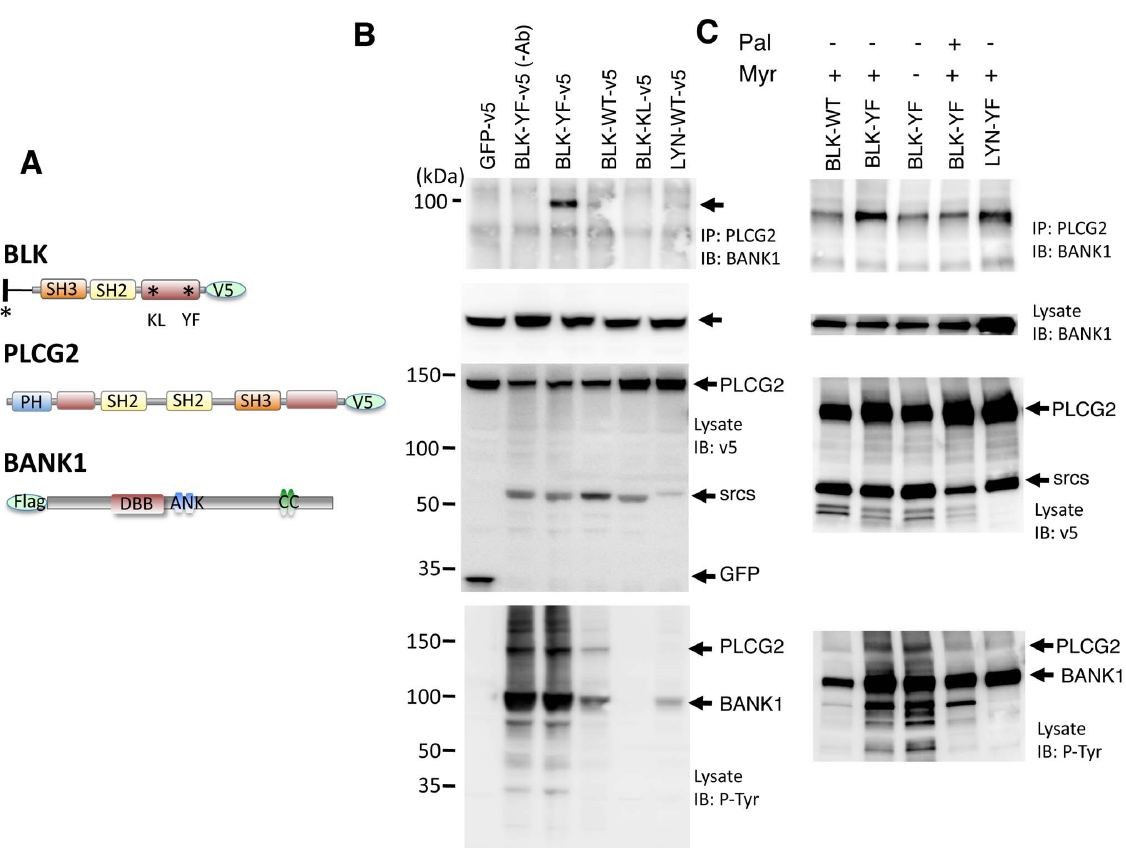
Figure 4. The constitutive-active form of BLK enhances the binding between BANK1 and PLCG2. (A) Schematic representation of the constructs used to study the association between BANK1 and PLCg2 in transfected HEK293 cells. The constructs coding for wild-type forms of BLK, LYN, GFP and PLCg2 or the indicated mutated forms were fused to the epitope V5 at the C-termini. BANK1 was targeted with the Flag epitope at the N- terminus. The catalytic domains of BLK and PLCg2 are shown in red. The kinase dead form (BLK-KL-v5) has a substitution K (lysine) to L (leucine) at position 269 and the constitutively active form (BLK-YF-v5) has a Y501F substitution that prevents the phosphorylation of the inhibitory tyrosine. The lipidation in the amino terminal of BLK is indicated as back line. The myristoylation site was deleted by G2V substitution (glycine to valine) and the addition of an extra by palmitoylated site by L3C substitution (leucine to cysteine). The Src homology 3 domains (SH3) that bind to proline-rich motifs are drawn in orange and the SH2 domains in yellow. The Pleckstrin homology domain (PH) that binds to phosphatidylinositol lipids is shown in blue. In BANK1 are shown the Dof/BCAP/BANK (DBB) motif (amino acids 199–327), the double ankyrin repeat-like (ANK) motifs (amino acids 339-402) and the putative coiled coil (CC) region (amino acids 677–705). (B) HEK293 cells were transiently co-transfected with plasmids coding for the wild-type form of BLK, its functionally mutated forms (KL and YF), LYN or GFP in addition to plasmids expressing BANK1 and PLCg2. The lysates were immunoprecipitated using anti-PLCg2 antibody (above) and immunoblotted sequencially with anti-BANK1 antibody, anti-V5 to detect PLCg2, Srcs kinases and GFP and anti-phosphotyrosine antibody. (C). Mutation of lipidation sites of the kinases influence the formation of the BANK1-PLCg2 complex and the overall tyrosine phosphorylation on PLCg2. The blots were interrogated as in